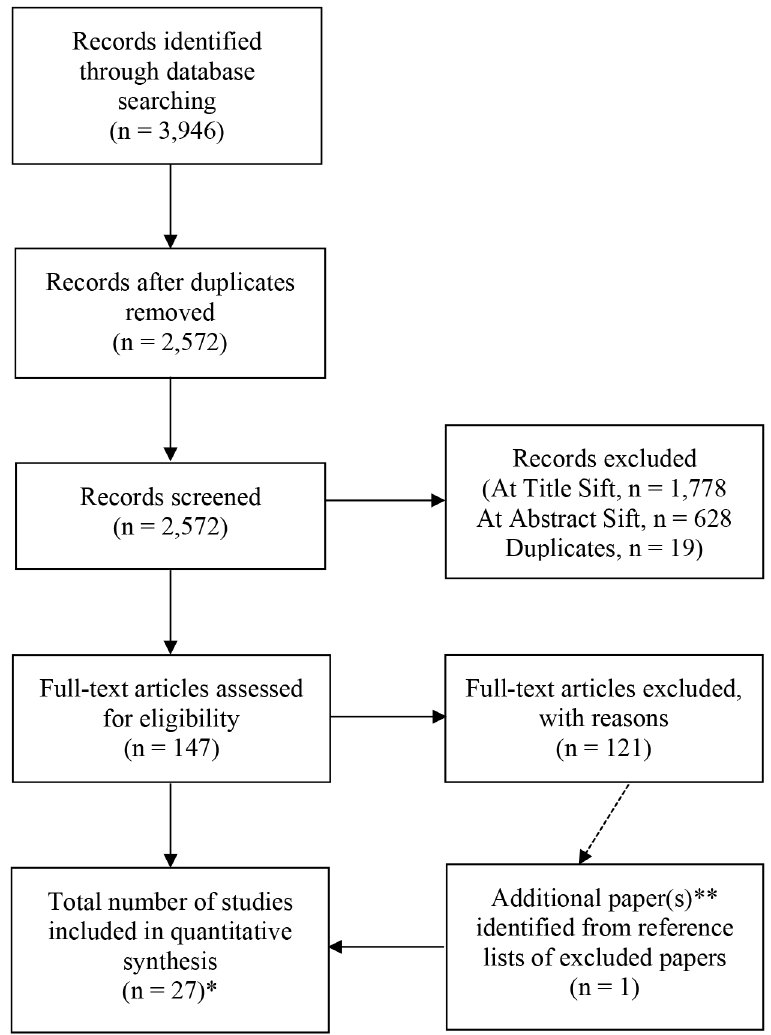
Figure 1. PRISMA flow diagram. Key : CVD=Cardiovascular diseases; RCT=Randomised controlled trial; SR=Systematic Review. *Of the 27 included publications: a) CVD, SR=9, RCT=3; b) Cancer, SR=6; and c) Diabetes, SR=7, RCT=2. **One paper was identified from assessment of reference lists of excluded papers, this had been excluded at abstract sift but was not considered relevant until reading the paper in